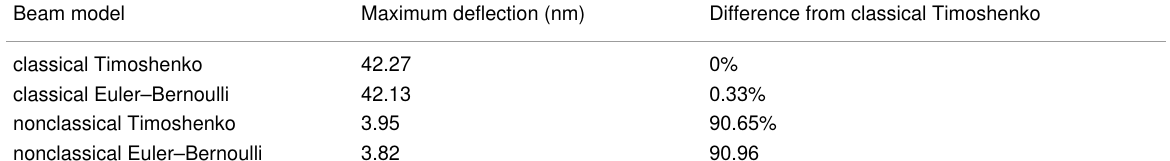
Table 4: Comparison of the maximum deflection of a cylindrical gold nanoparticle with the length of 25 µm and aspect ratio of 30. Beam model